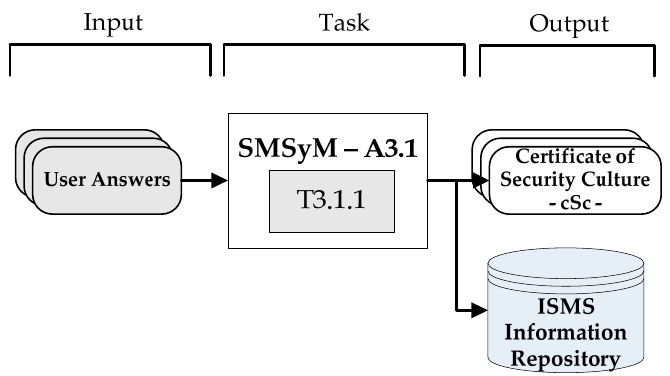
Figure 3. Future Internet 2016 , 8 , 30